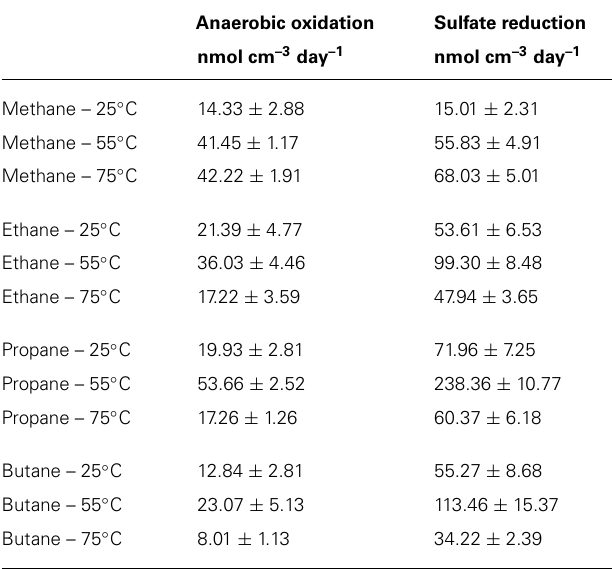
Table 1 |Volume-specific rate measurements of the anaerobic oxidation of methane, ethane, propane, and butane and sulfate reduction in batch reactors incubated at 25, 55, and 75 ◦